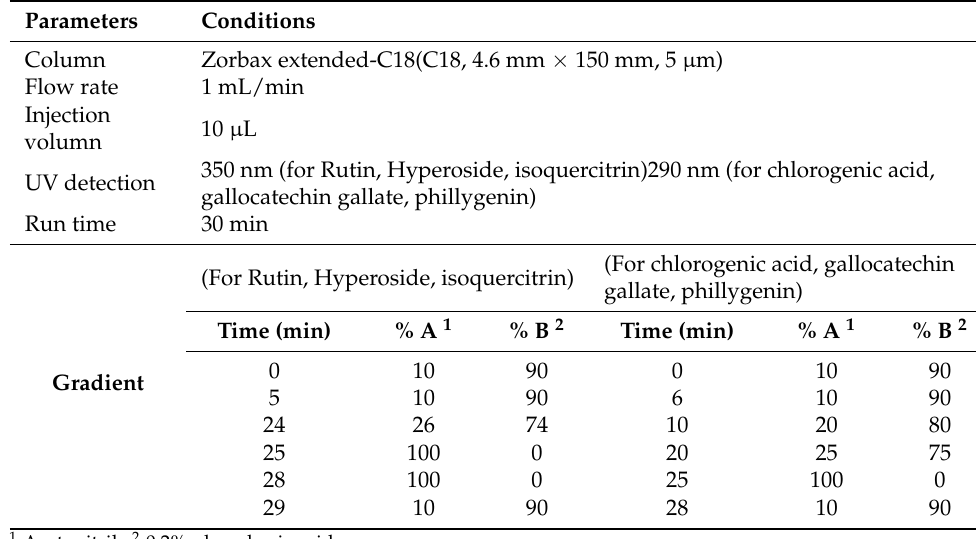
Table 2. HPLC analysis condition for CJ extract.